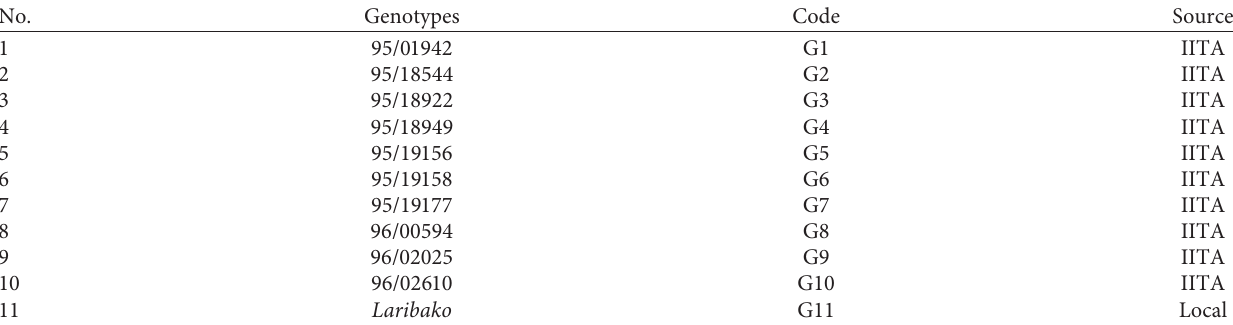
Table 1: List of the genotypes used for the study.